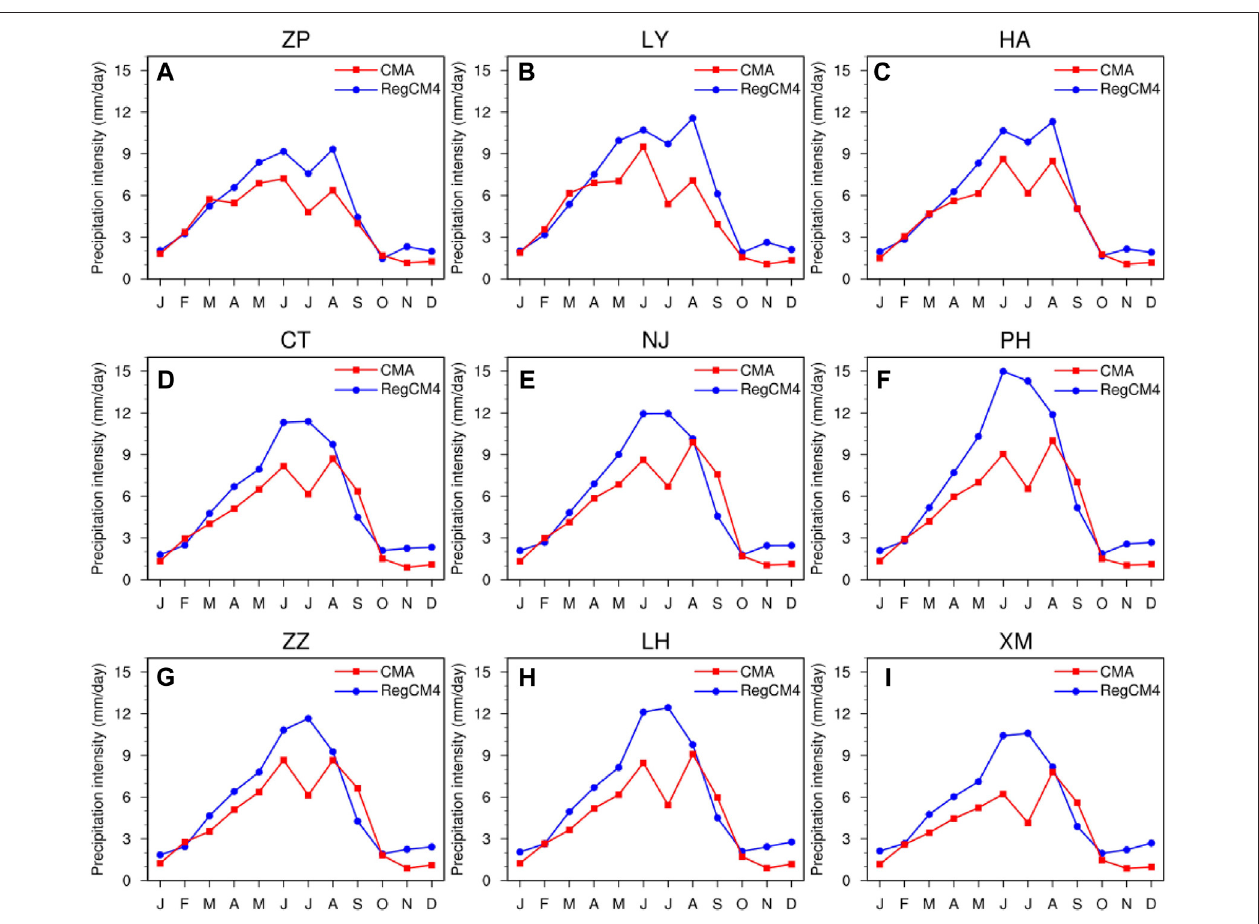
FIGURE 2 | The seasonal cycle of monthly mean precipitation (mm/day) at (A) Zhangping, (B) Longyan, (C) Huaan, (D) Changtai, (E) Nanjing, (F) Pinghe, (G) Zhangzhou, (H) Longhai, and (I) Xiamen meteorological stations during 1986 – 2005. The red lines are for observations and blue lines for RegCM4 outputs driven by